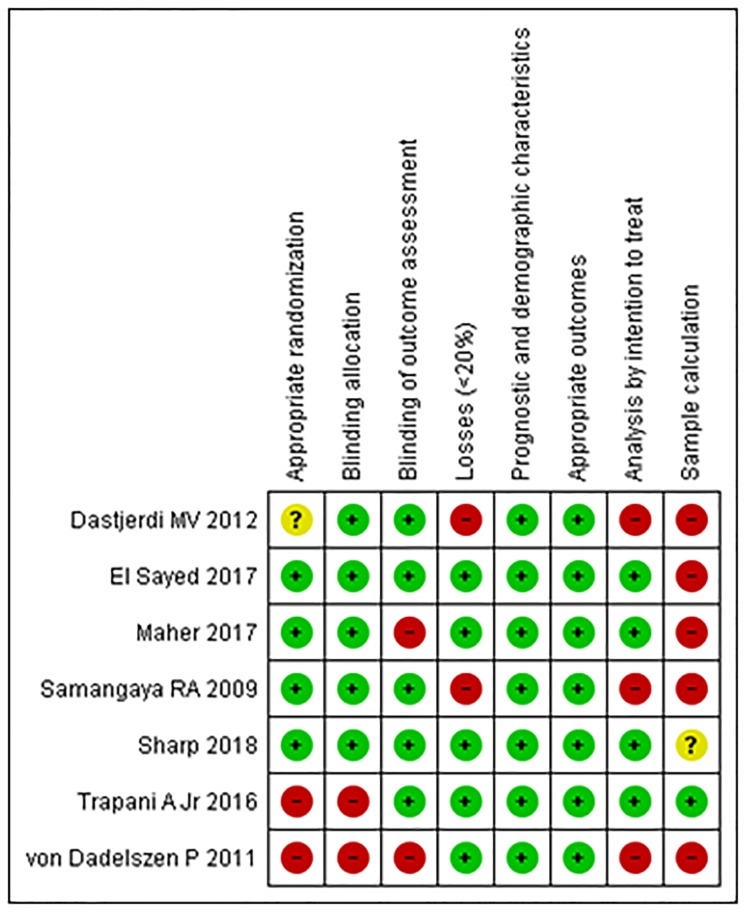
Risk of bias for each study.